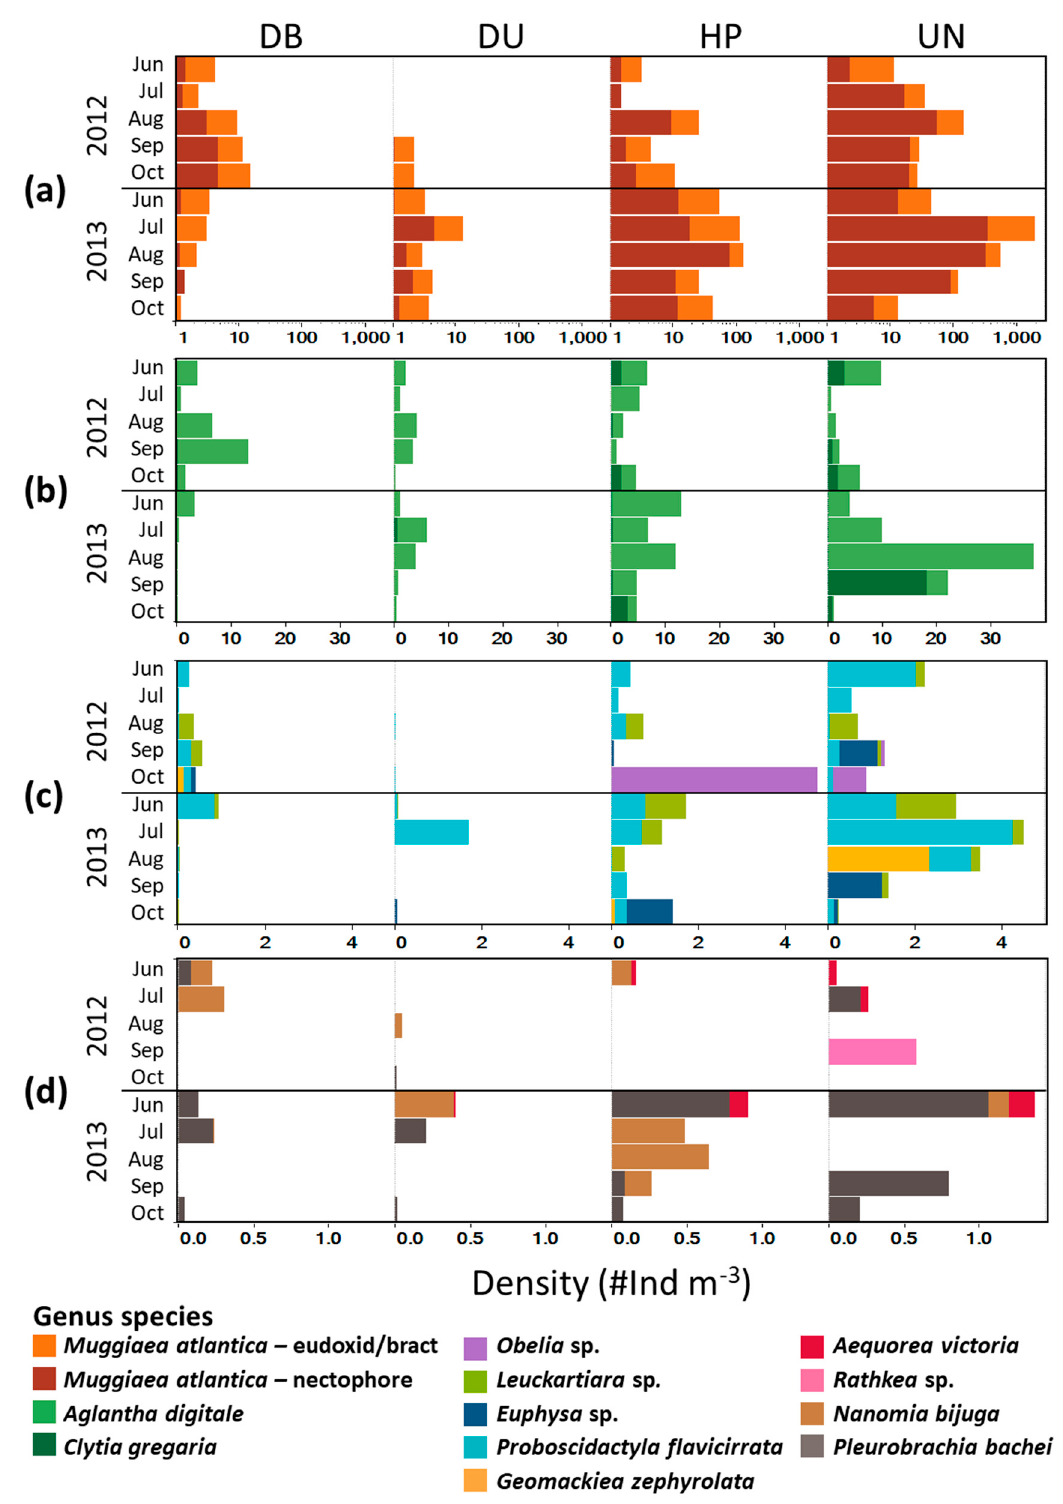
Figure 3. Temporal and spatial patterns in species abundances (Ind m − 3 ) of ( a ) dominant, Muggiaea atlantica , ( b ) more abundant, ( c ) rare, and ( d ) very rare jellyfish at four stations in Hood Canal. M. atlantica’s individual predatory gastrozooids are separated by color (nectophores versus eudoxids/bracts). Species with less than 4 occurrences were not plotted. Note different x-axis scales and log-scaling of ( a ).